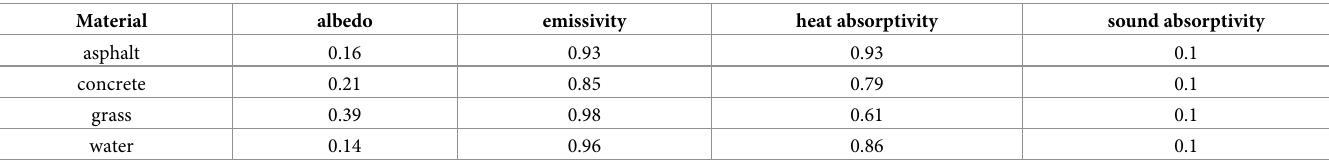
Table 1. Material properties used in this